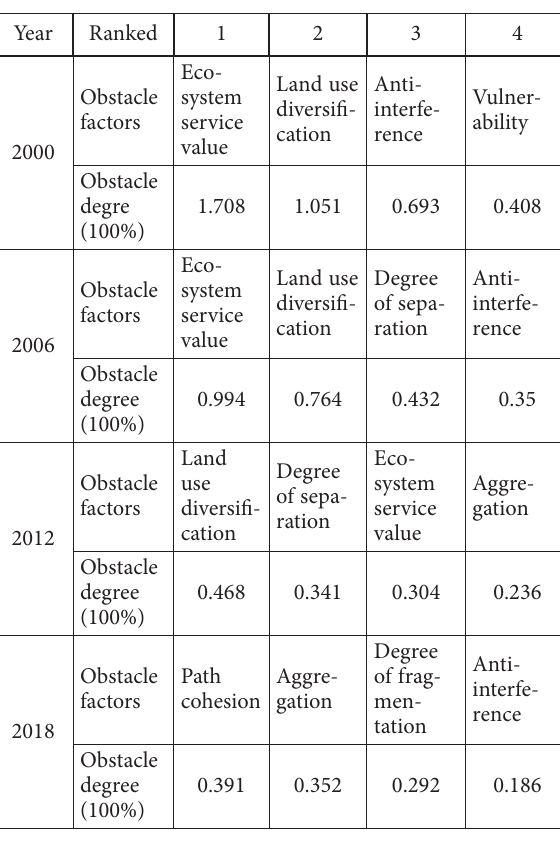
Table 6. The main obstacles to landscape ecological